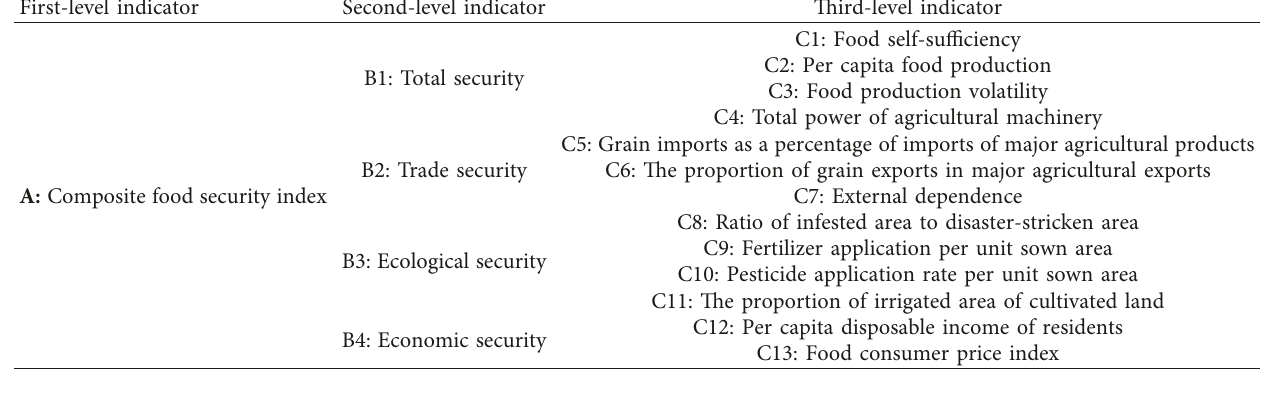
Table 1: Construction of indicator system of China’s food security early warning system.